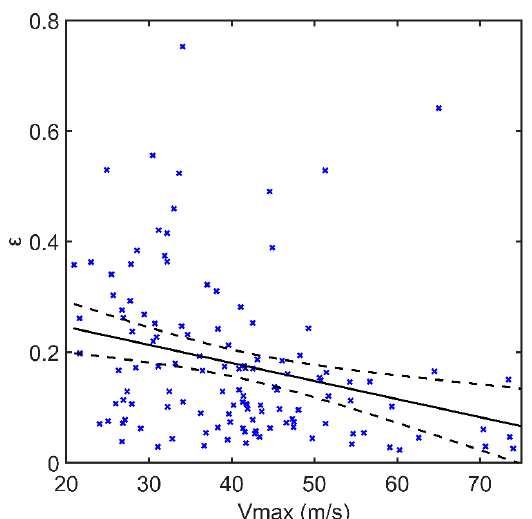
Figure 4. Asymmetry parameter ( ε ) versus TC intensity ( V max ). Black solid and dashed lines represent linear regressions and 95% confidence intervals for the fits, respectively. Table 2. Linear regression coe ffi cients for the asymmetry parameter ( ε ) versus TC intensity ( V max ) [ ε = a + bV max ] (Figure 4). Asymmetry Parameter